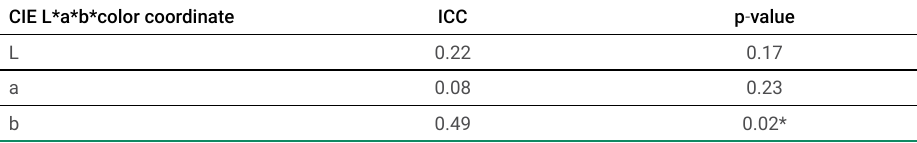
Table 3. Inter-device reliability of color coordinates (L*, a* and b*) CIE L*a*b*color coordinate